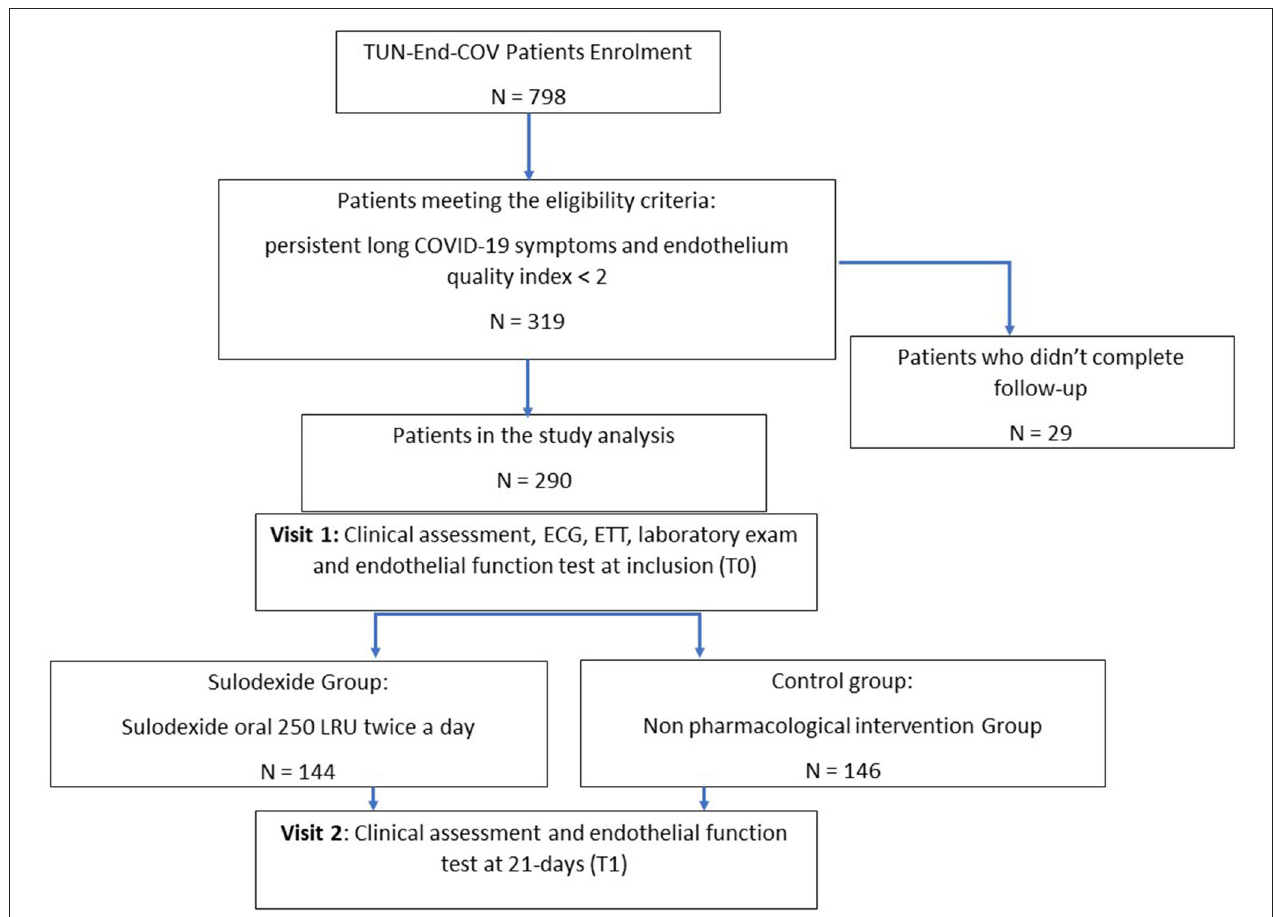
FIGURE 1 | The study flow